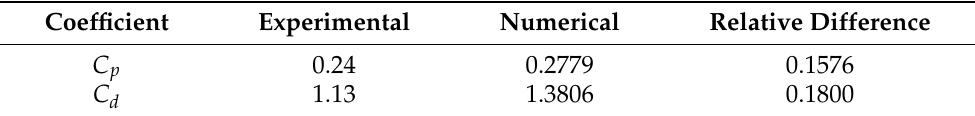
Figure 28. Time evolution of the drag coefficient C d for case #5 (blue line with crosses) and experi- mental data (red line with plus). The black line is the Cp mean value starting at 0.5 s. Table 8. Coefficient values with their relative differences with the experiment